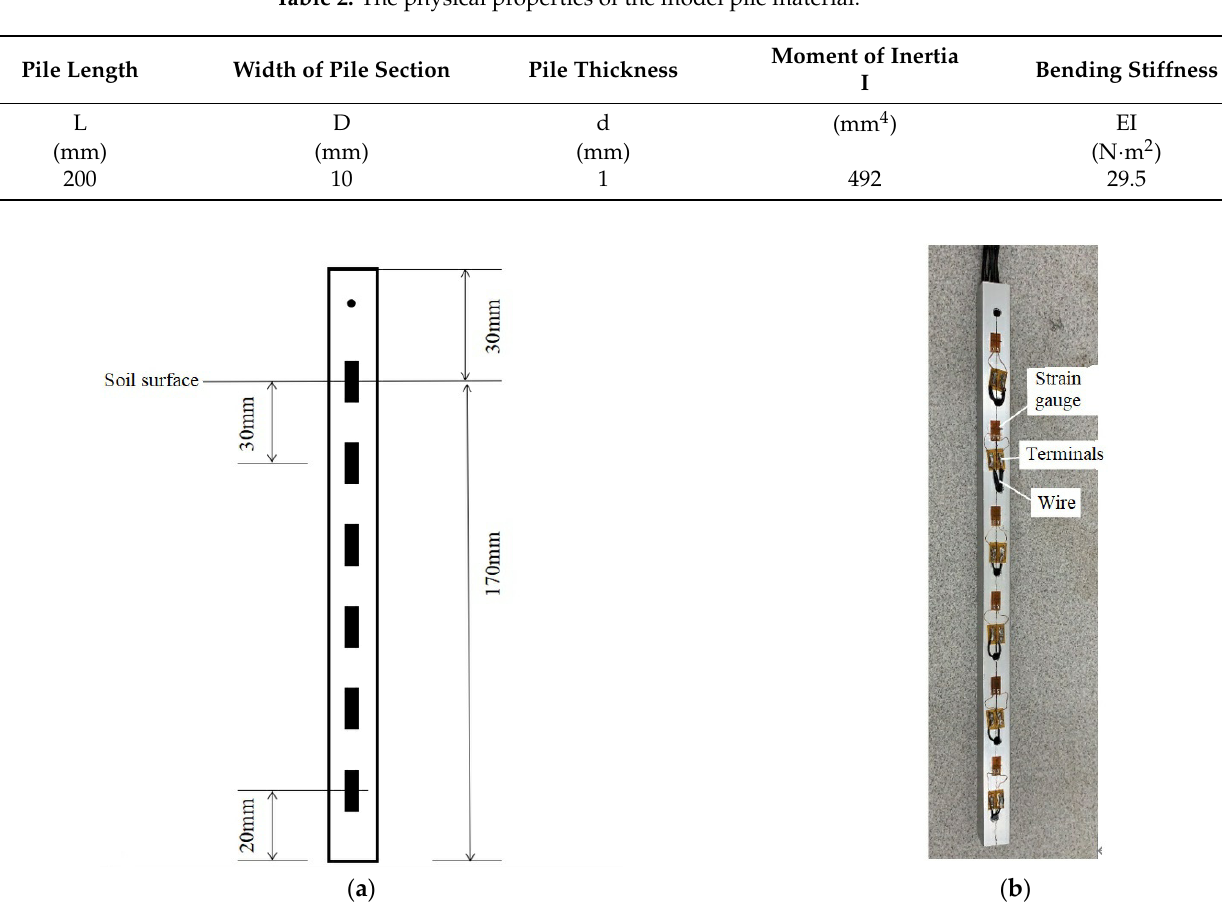
Figure 2. Model pile. ( a ) Layout distance of pile body strain gauge. ( b ) Model pile.